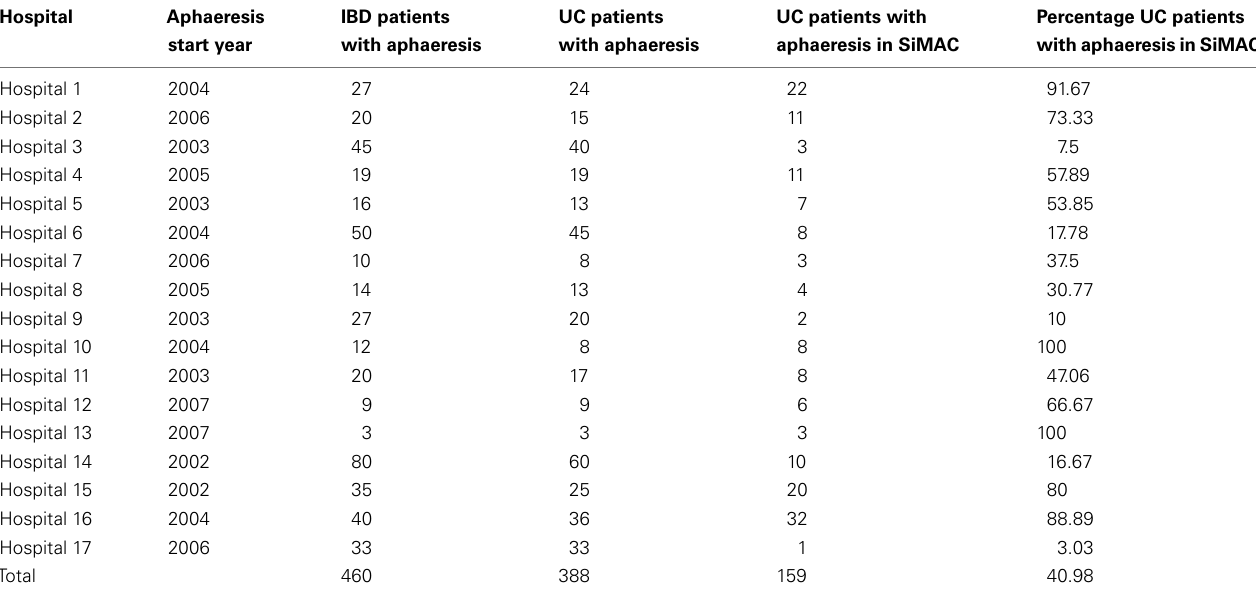
Table 2 | Aphaeresis in the participating hospitals that responded to the